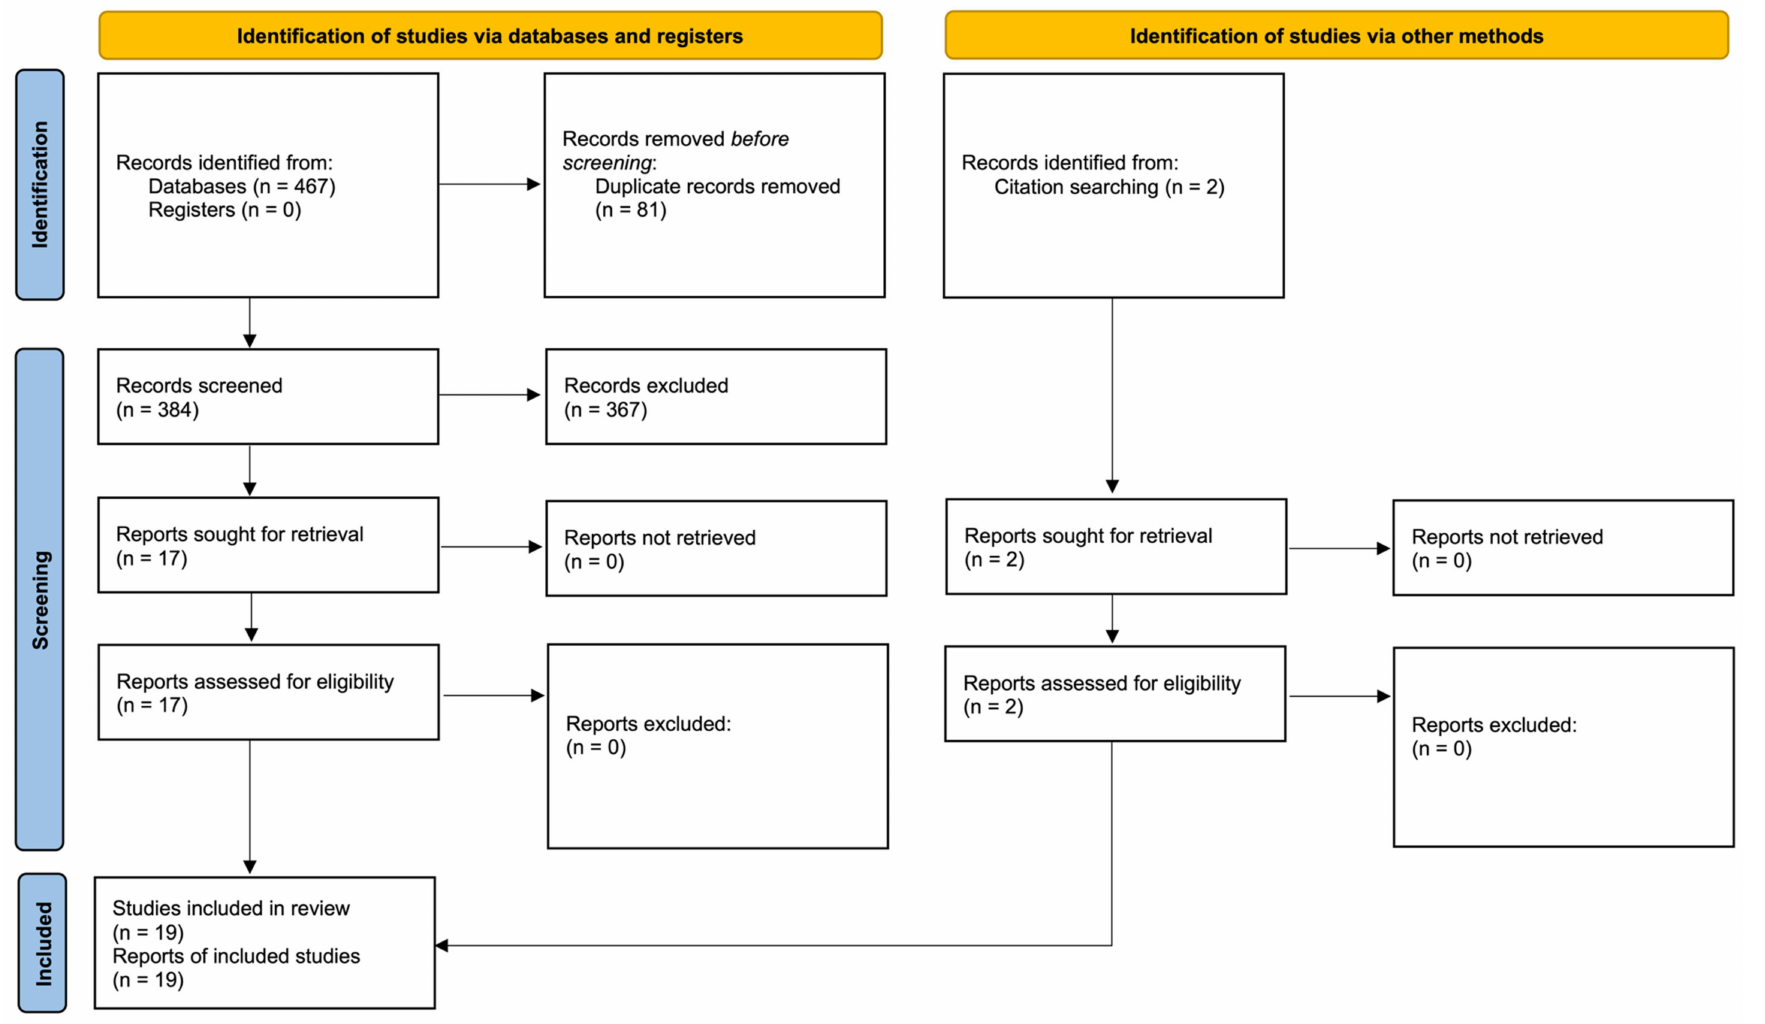
Figure 2. Schematic illustration of the study selection process. Based on PRISMA 2020 flow